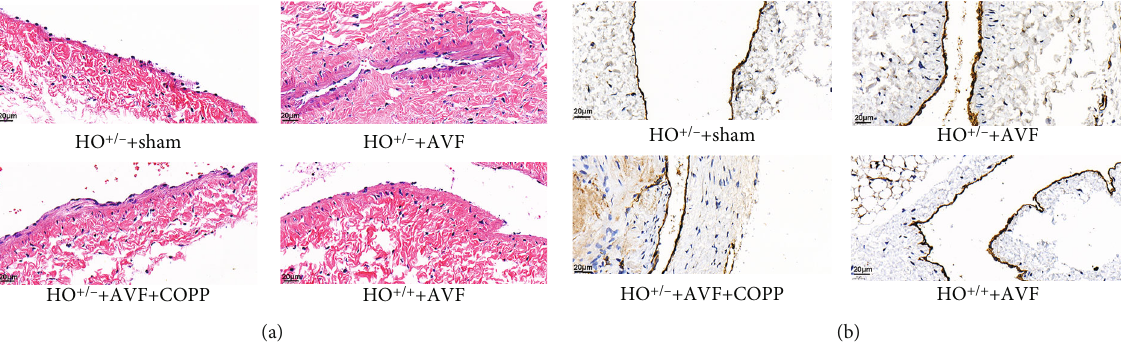
Figure 4: Histopathology and immunohistochemical (IHC) analyses. (a) The morphology of the vascular tissues from the arteriovenous anastomosis site stained with hematoxylin-eosin. (b) The expression of CD31 measured by IHC staining. Scale bar = 20 μ m. Table 2: The contents of serum biochemical indexes in di ff erent groups.